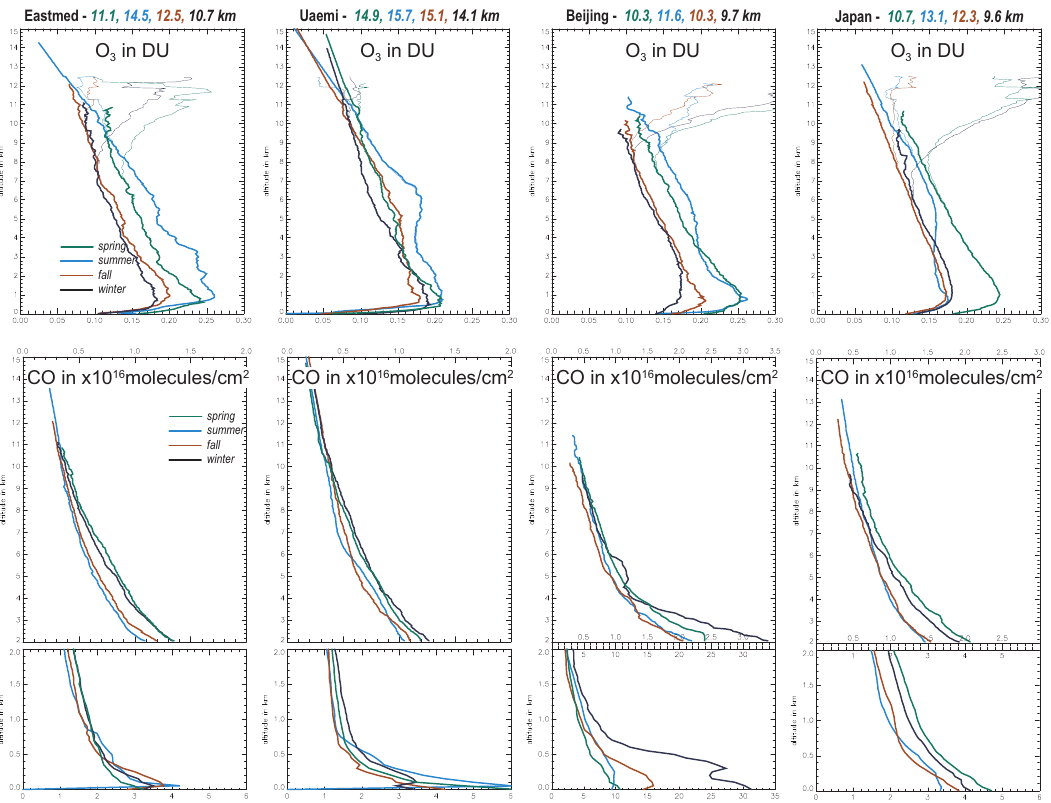
Fig. 11. Same as Fig. 8 but for Eastmed, Uaemi, Japan and Beijing, from left to right. Note that for CO, the horizontal scale changes exclusively for Beijing in the 0–2km section of the graph, and for both Japan and Beijing in the 2–15km section of the